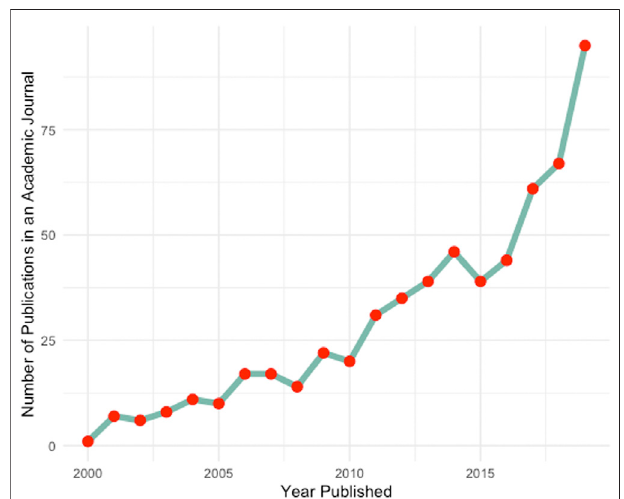
FIGURE 1 | Several academic publications over the last 20 years that have included in the title, abstract or keywords: “ Virtual Reality ” or “ VR ” and “ EMG ” (and/or “ electromyography ” , “ PPG ” , “ photoplethysmography ” ). Search made using